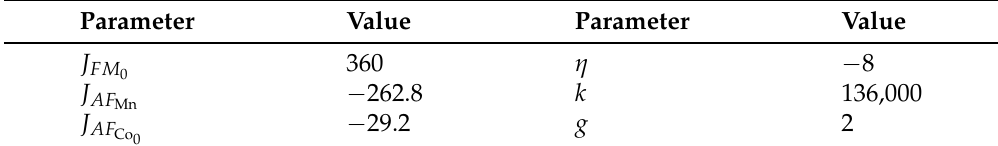
Table 1. The simulation parameters. Parameter Value Parameter